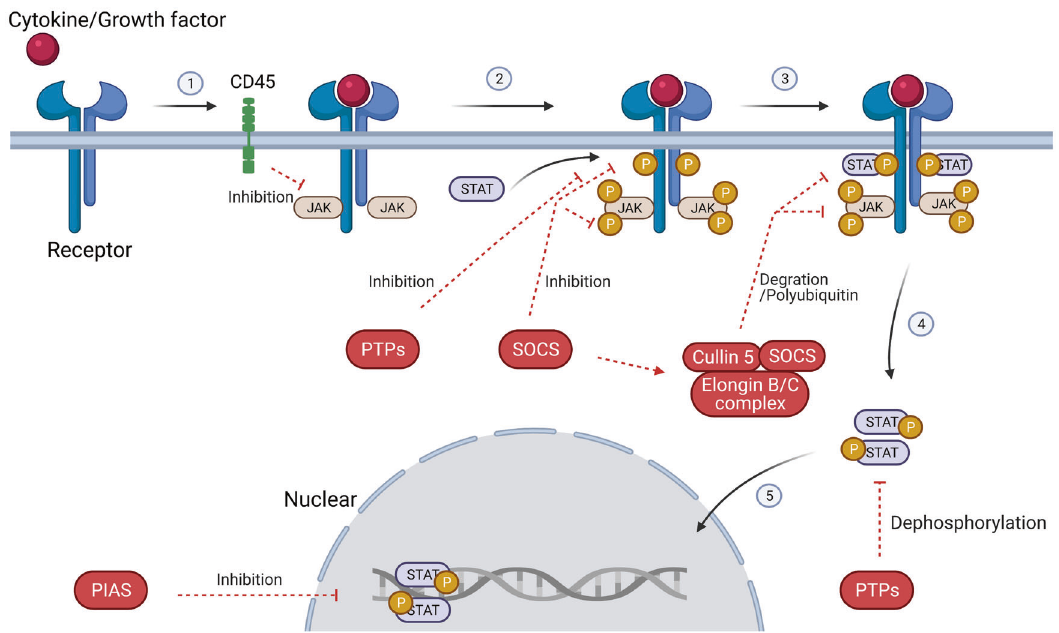
Fig. 3 Activation and negative regulation of JAK/STAT signaling pathways. Black arrows indicate the activation process. Red dotted arrows indicated negative regulation. Activation of the JAK/STAT signaling pathway: (1) cytokines and growth factors bind to their corresponding receptors, leading to receptor dimerization and recruitment of related JAKs; (2) JAK activation leads to tyrosine phosphorylation of the receptors and formation of docking sites for STAT; (3) STATs are phosphorylated by tyrosine; (4) STATs dissociate from the receptor to form homodimers or heterodimers; (5) STAT dimers enter the nucleus, bind to DNA, and regulate transcription. Negative regulation of the JAK/STAT signaling pathway: There are three main types of proteins involved in the negative regulation of the JAK/STAT signaling pathway: the PIAS (protein inhibitor of activated STAT), CIS/SOCS (suppressor of cytokine signaling) family, and PTPs (protein tyrosine phosphatase). PIAS mainly interacts with STAT dimers to inhibit STAT binding to DNA, thereby blocking JAK/STAT signal transduction. The CIS/SOCS family negatively regulates the JAK/STAT pathway in three ways: (1) binding to a tyrosine kinase receptor to block the recruitment of STAT; (2) binding directly to JAK to inhibit its kinase activity; (3) forming an elongin B/C-cullin5 complex that degrades JAK or STAT bound to the SOCS protein through polyubiquitination and proteasome degradation. PTPs inhibit the JAK/STAT pathway by interacting with JAK, STAT, or receptors to (1) dephosphorylate the STAT dimer; (2) interact with the receptor to dephosphorylate the related JAK; and (3) in the case of CD45 (a transmembrane PTP) inhibits the phosphorylation of JAK. Created with inhibitor of activated STAT (PIAS), SOCS/CIS family members, and PTPs (protein tyrosine phosphatases) (Fig. 3). SOCS/CIS family . The SOCS protein family are intracellular proteins that include CIS, SOCS1, SOCS2, SOCS3, SOCS4, SOCS5, SOCS6, and SOCS7. Activated STATs dimerize and enter the nucleus to induce SOCS expression and the SOCS proteins bind to phosphorylated JAK and its receptor to negatively regulate the JAK – STAT signaling pathway. SOCS mainly negatively regulates the JAK/STAT pathway in three ways. (1) It binds to the phosphotyrosine on the receptor to prevent STAT recruitment to the receptor; CIS binds stably to the tyrosine-phosphorylated β chain of the IL-3 receptor and the tyrosine-phosphorylated EPO receptor. 162 (2) It directly and speci fi cally binds to JAK or its receptor to inhibit the kinase activity of JAK. For example, SOCS3 binds to JAK and its receptor gp130 simultaneously. SOCS3 targets the IL-6 family cytokine-receptor complex containing the signaling receptor gp130. After the SH2 domain of SOCS3 binds to phosphorylated Tyr759 of gp130, SOCS3 Ig-like receptors (KIR) bind to gp130-related JAK in a nonphosphorylation-dependent manner. Upon SOCS3 binding, the substrate-binding groove of JAK is hidden, inhibiting the JAK/STAT signaling pathway. 163 The SH2 domain of the SOCS1 protein can target the activation loop of JAKs, and SOCS1 can also directly inhibit JAK tyrosine kinase activity through KIR. 164 (3) The SOCS proteins interact with the elongation protein B/C complex through its C-terminal SOCS box and simultaneously binds to the cullin5 scaffold protein to form an elongation protein-cullin-SOCS3 E3 ubiquitin-linked enzyme com- plex. 165 This complex undergoes polyubiquitination, and the